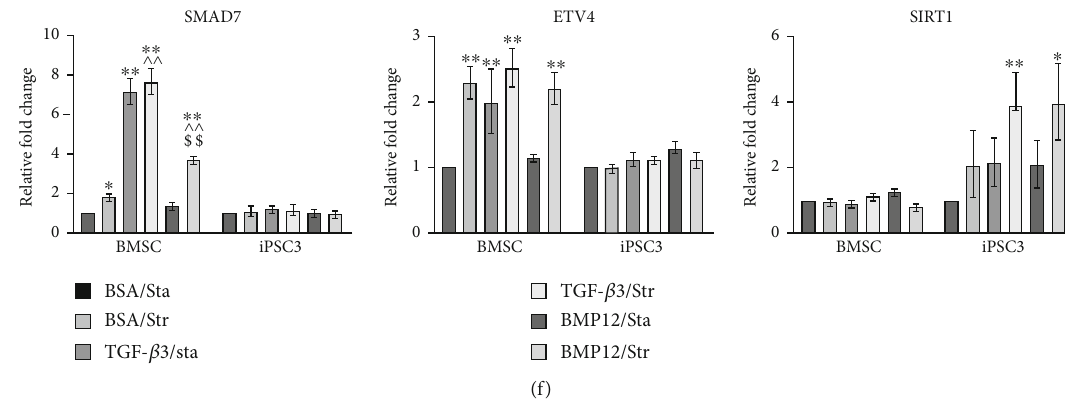
Figure 6: E ff ects of tenogenic stimuli on the expression of signaling factors. (a) BMSCs and teno-iPSC were treated with vehicle medium or TGF- β 3 (20 ng/mL) for 1 hr, and whole cell lysates were blotted for phosphorylated SMAD3 and a-tubulin. (b) BMSCs and teno-iPSCs were treated with vehicle medium or BMP12 (20 ng/mL) for 1 hr, and whole cell lysates were blotted for phosphorylated SMAD3 (p-SMAD3) and a-tubulin. (c) Cells were treated as in Figure 1, and the expression of SMAD7 , ETV4 , and SIRT1 was determined by qPCR. ∗ Data were compared to BSA control; # data were compared to the 4 ng/mL group. (d) Cells were treated as in Figure 2, and the expression of SMAD7 , ETV4 , and SIRT1 was determined by qPCR. (e) Cells were treated as in Figure 4, and the expression of SMAD7 , ETV4 , and SIRT1 was determined by qPCR. ∗ Data were compared to the GFP/BSA group, and # data were compared to the MKX/BSA group. (f) Cells were treated as in Figure 5, and the expression of SMAD7 , ETV4 , and SIRT1 was determined by qPCR. ∗ Data were compared to the BSA control group; ^ data were compared to BSA/Str; $ data were compared to